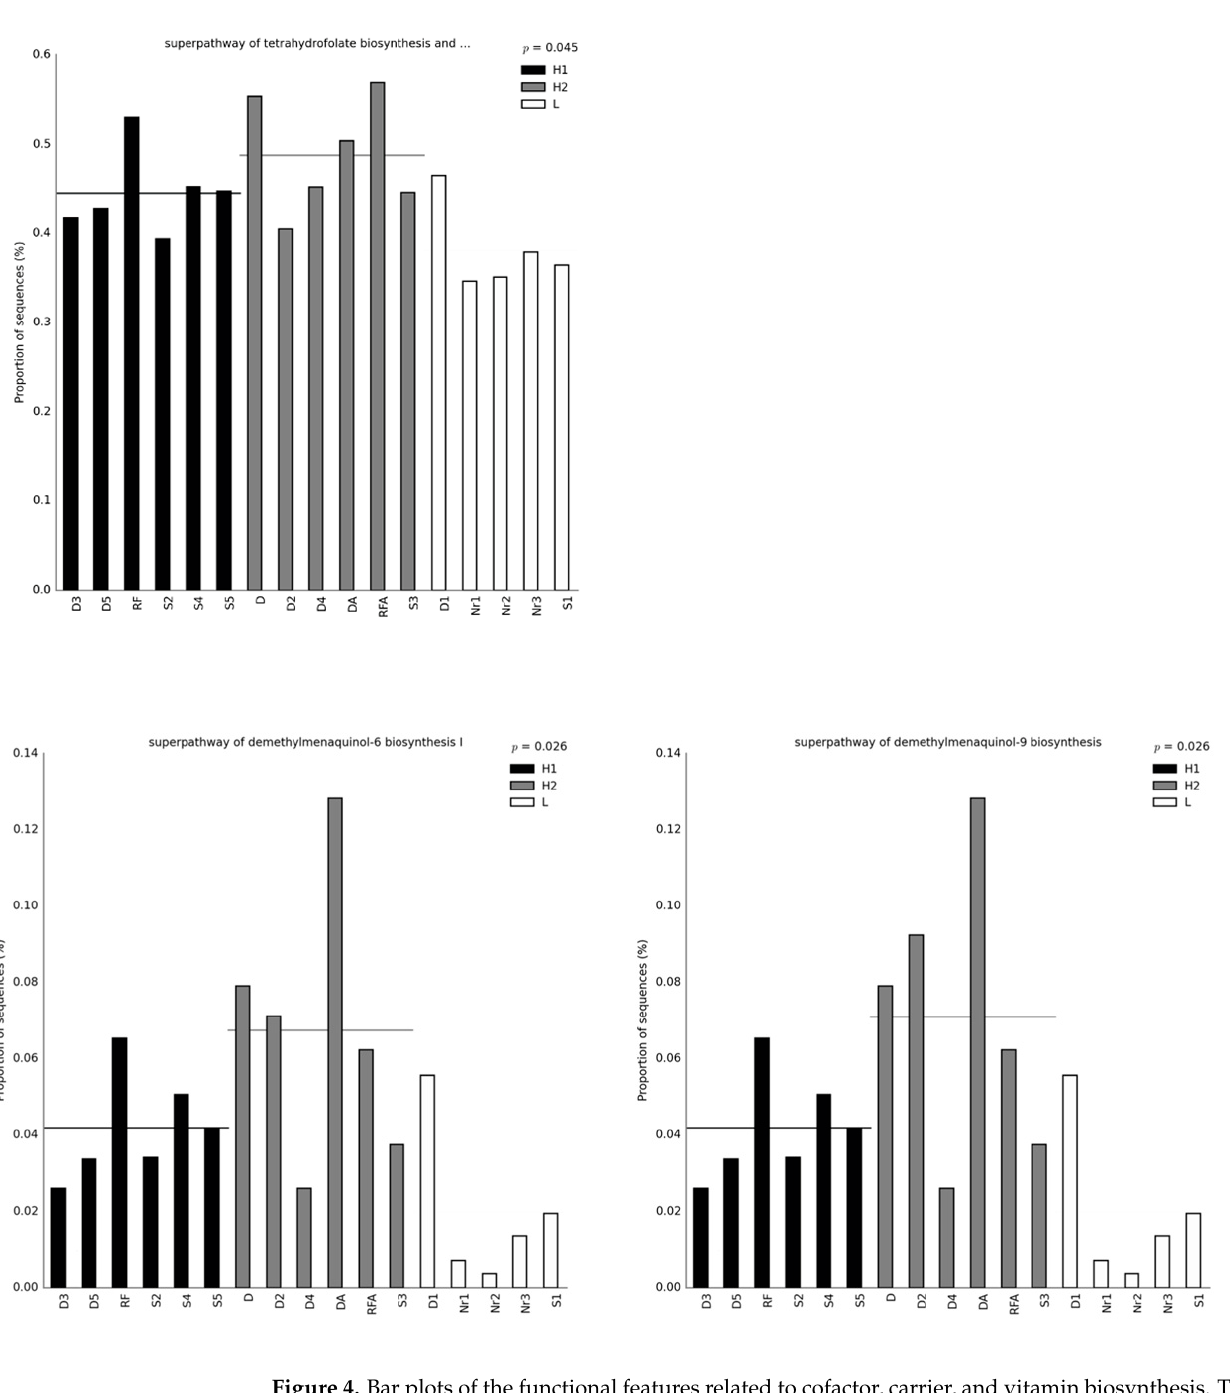
Figure 4. Bar plots of the functional features related to cofactor, carrier, and vitamin biosynthesis. The x-axis indicates the samples grouped into three groups. H1 represents the voltage outputs of soils larger than 50 mV with black. H2 represents the voltage outputs of the soils lower than 50 mV with gray. L represents the soils without MFCs processing with white. The y-axis indicates the relative abundance. The horizontal line crossing the bar represents the